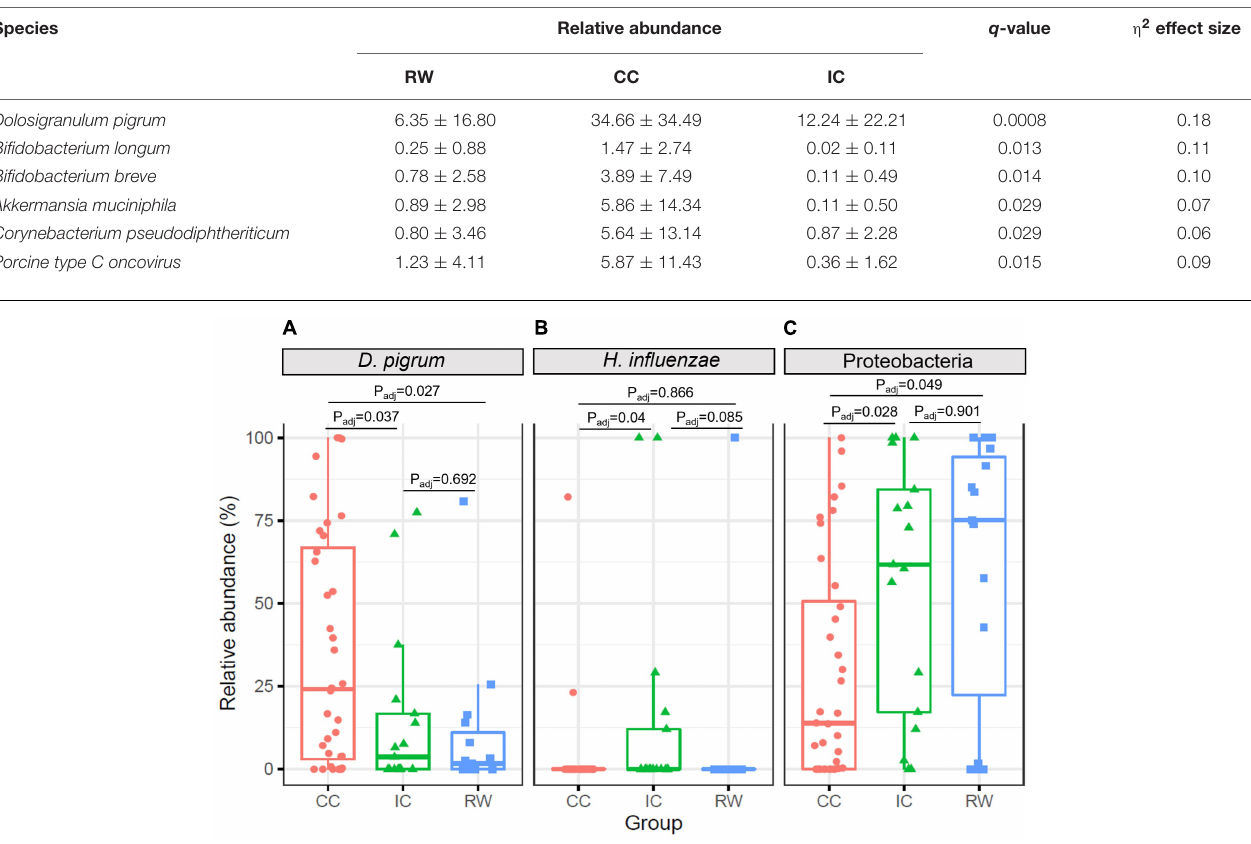
TABLE 1 | Microbial species with medium to high effect size across different subject groups identified by STAMP. Species